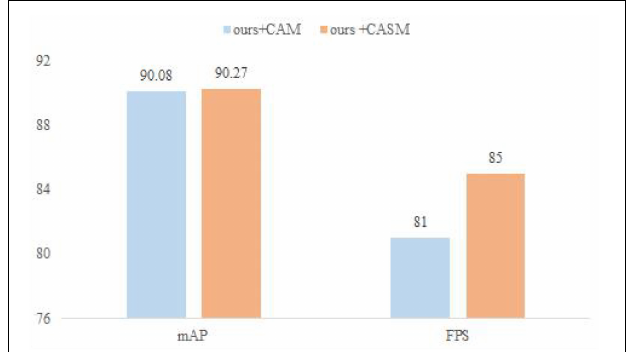
FIGURE 9 | Effects of different attention modules of coordinate attention shuffle mechanism (CASM) and CAM on model recognition ability.